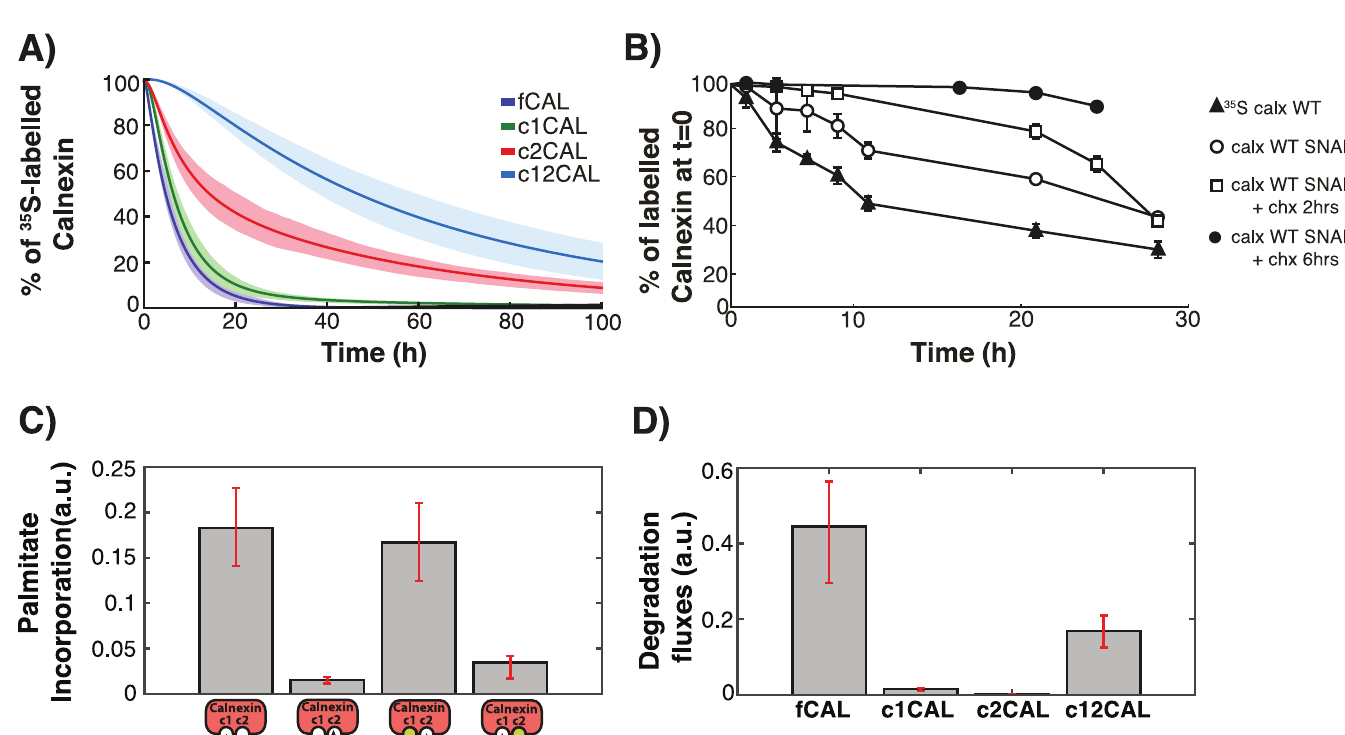
Fig 5. Kinetics of calnexin palmitoylation and stability. A: The decay curves were predicted for the different palmitoylation species: fCAL represent folded calnexin, c1CAL and c2CAL the single palmitoylated species, c12CAL double palmitoylated calnexin. Solid line is the mean of the simulations of 382 models; shaded area is defined by the first and the third quartile of the simulations of 382 models (details of the in silico labelling experiment can be found in the Expanded View). B: Decay profiles were determined for WT calnexin either by 35 S Cys/Meth labelling ( 35 S calx WT) and by SNAP labeling (Calx WT SNAP). C: The model was simulated until it reached steady state and the values of the palmitoylation rates under steady state conditions were plotted. Error bars correspond to first and third quartile of the simulations of 382 models (details of the in silico labelling experiment can be found in the Expanded View). D: The model was simulated until it reached steady state and the values of the degradation rates under steady state conditions were plotted. Error bars were determined as in (C).